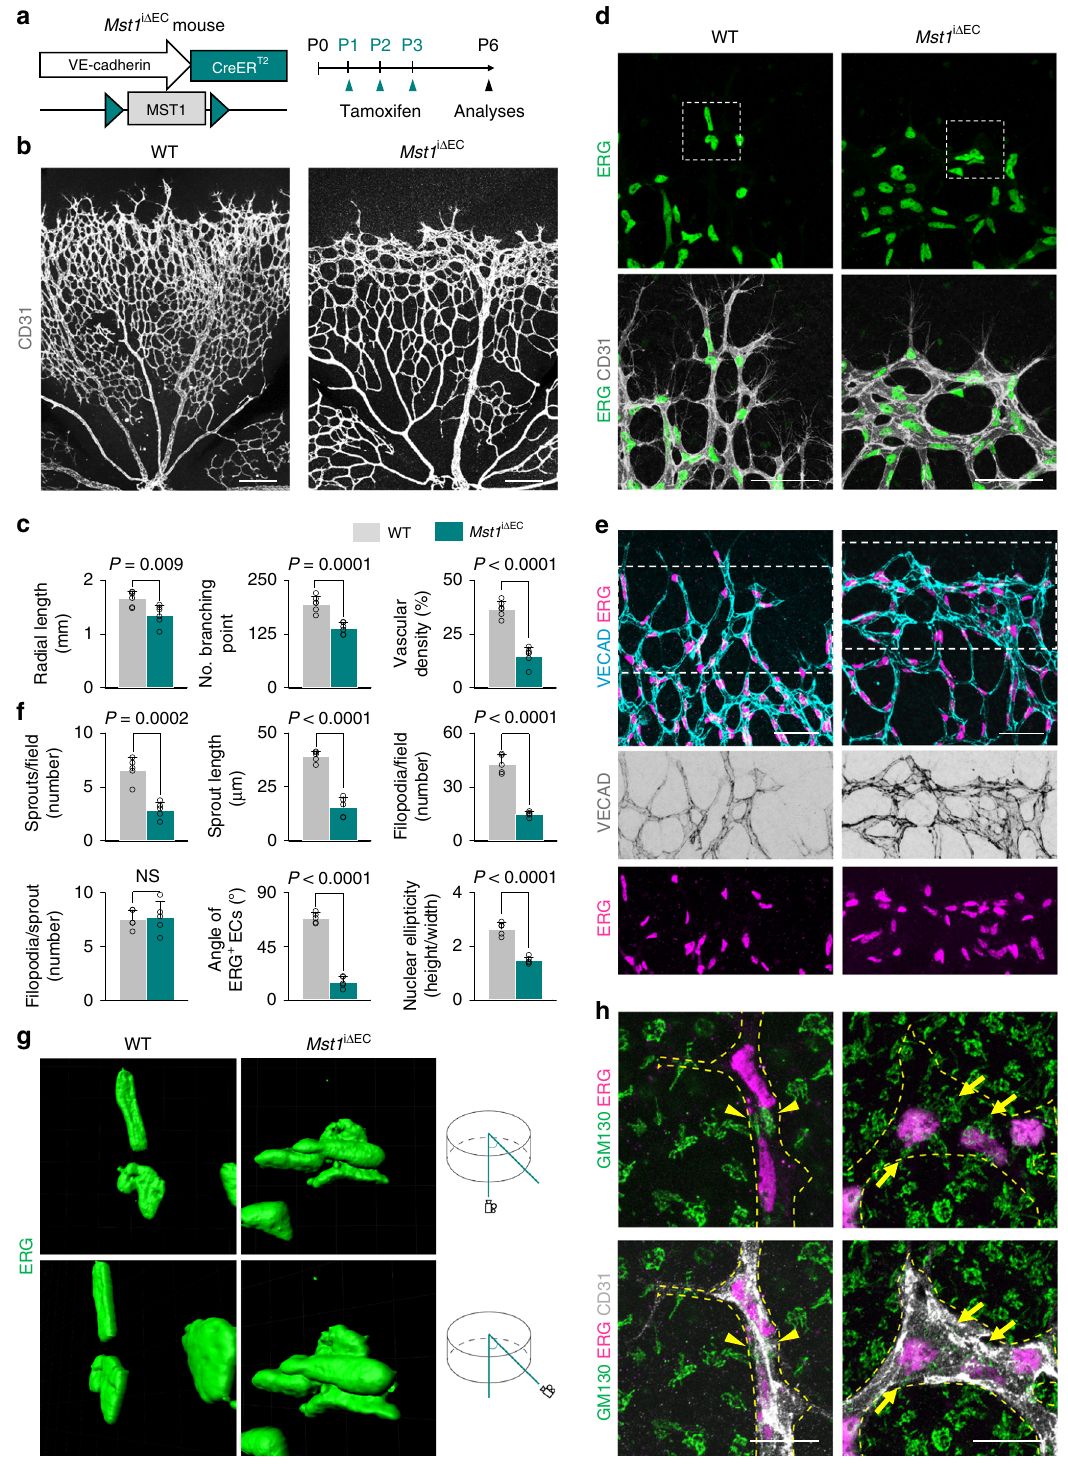
mice at P12 (Fig. 2i – l). These results indicate that endothelial MST1 is critical for perpendicular vascular